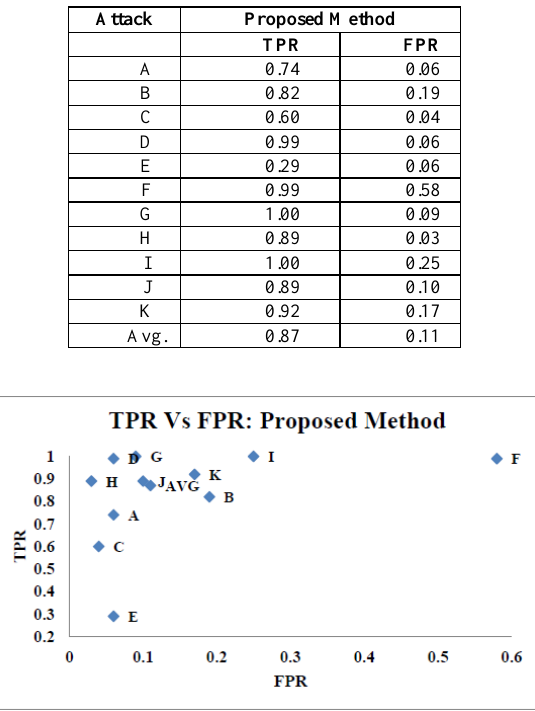
Figure 3. TPR vs. FPR for proposed for various attacks.